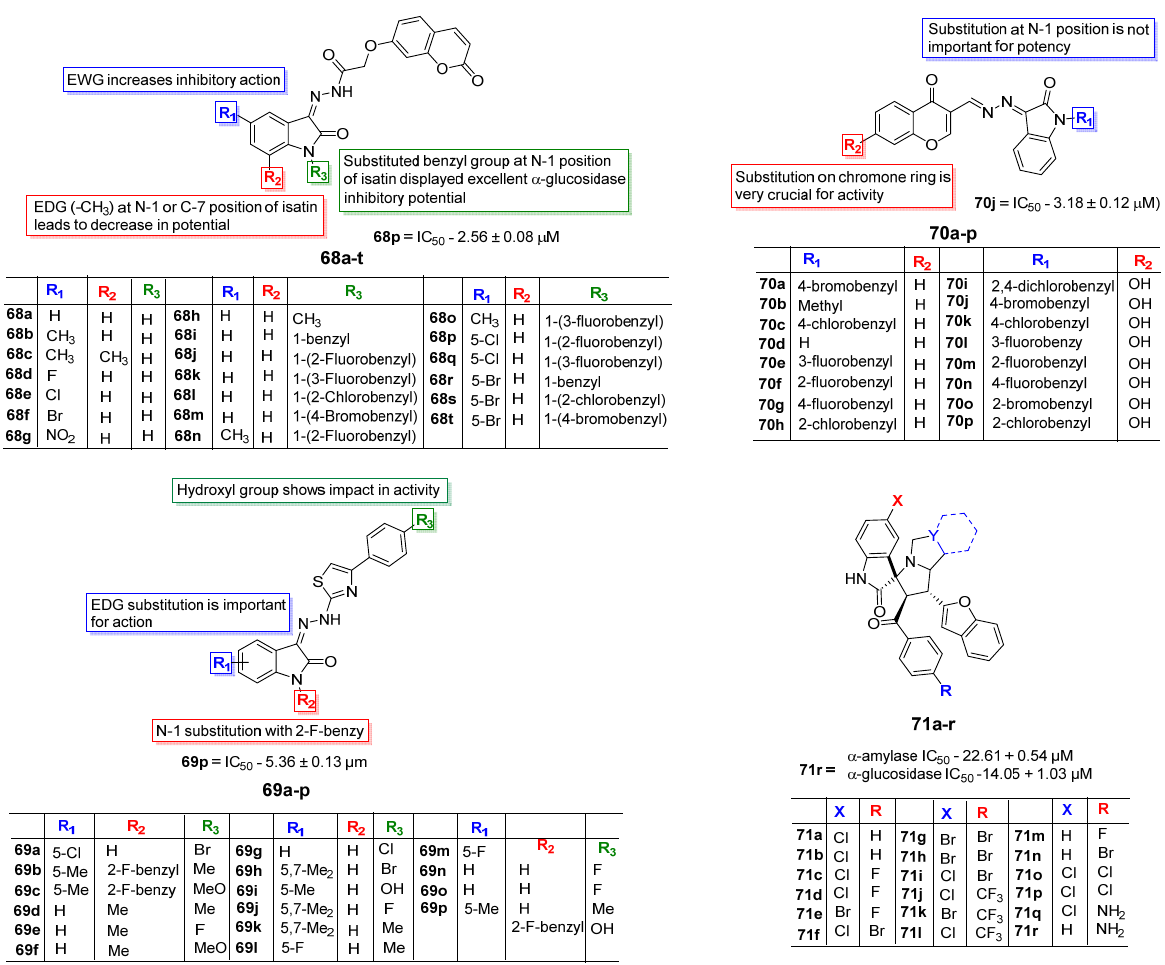
Figure 9. Chemical structures and SAR features for anti-diabetic profile of isatin